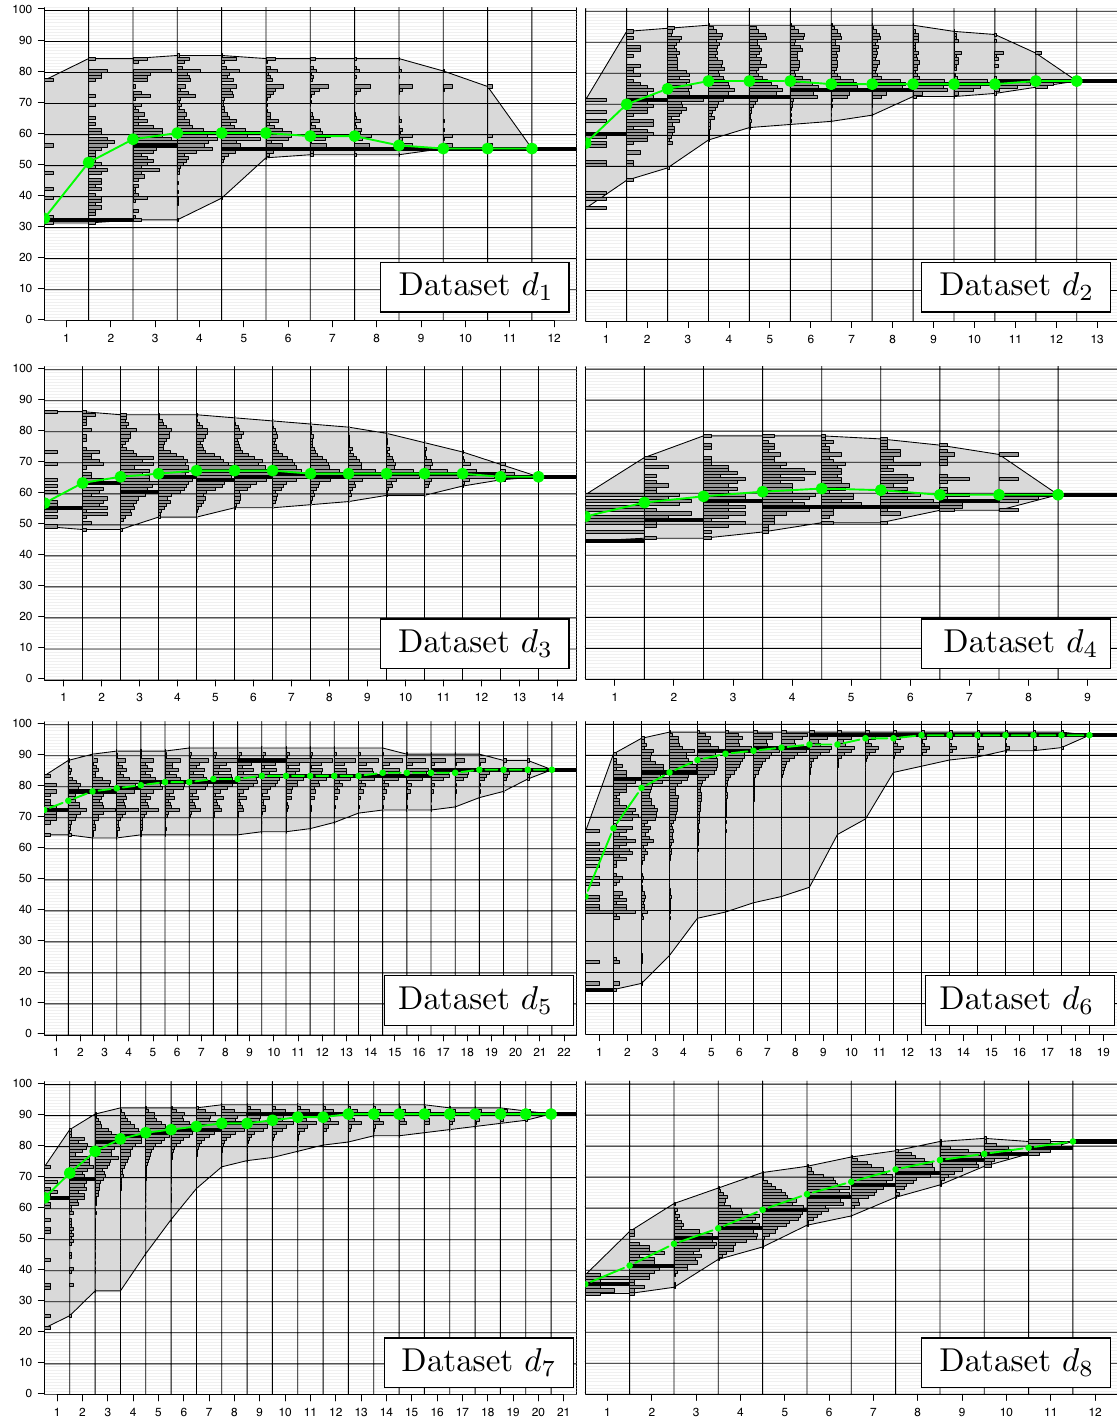
Figure 6. Fitness landscapes. The figure shows the fitness landscapes of e- k -NN, k = 1 , for datasets d 1 − d 8 . The figures for k ∈ { 3, 5, 7 } can be found in the supplementary information. A fitness landscape provides the accuracies of all analyzed feature combinations. They are organized in histograms for the individual feature set sizes ˆ n (column-wise). The height of a histogram is normalized by the mode of the corresponding set. The underlying polygon combines the minimal and the maximal accuracies achieved for ˆ n . For each feature combination, the mode is shown in black within the single histograms. The median of each combination is depicted in